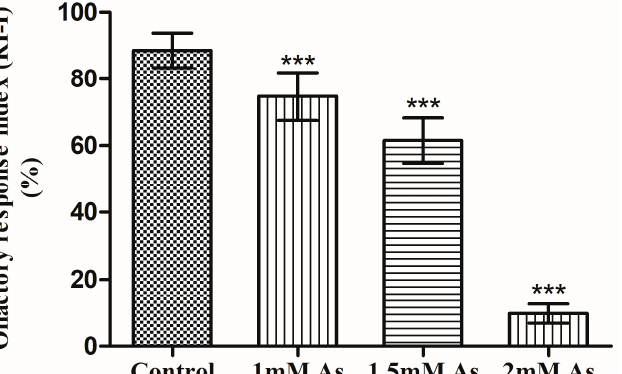
Figure 6. The graph represents an olfactory response index of control, 1 mM, 1.5 mM, and 2 mM arsenic-treated flies. The error bar represents the means ± S.D. The significant mean difference ( p < 0.05) between RI-I mean of the different samples of flies were analyzed by a one-way analysis of variance (ANOVA) (*** p < 0.0001; R-squared = 0.771).